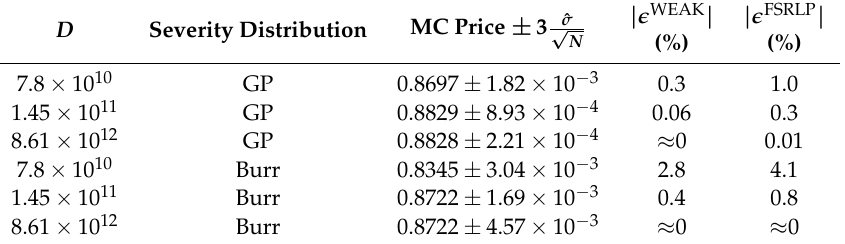
Table 4. Comparison of index-linked zero-coupon (ZC) catastrophe (CAT) bond prices, under the weak approximation, MC estimation and the first-order single risk loss process (FSRLP) approximation, for different threshold levels D and different underlying loss severity distributions. GP, generalized Pareto.